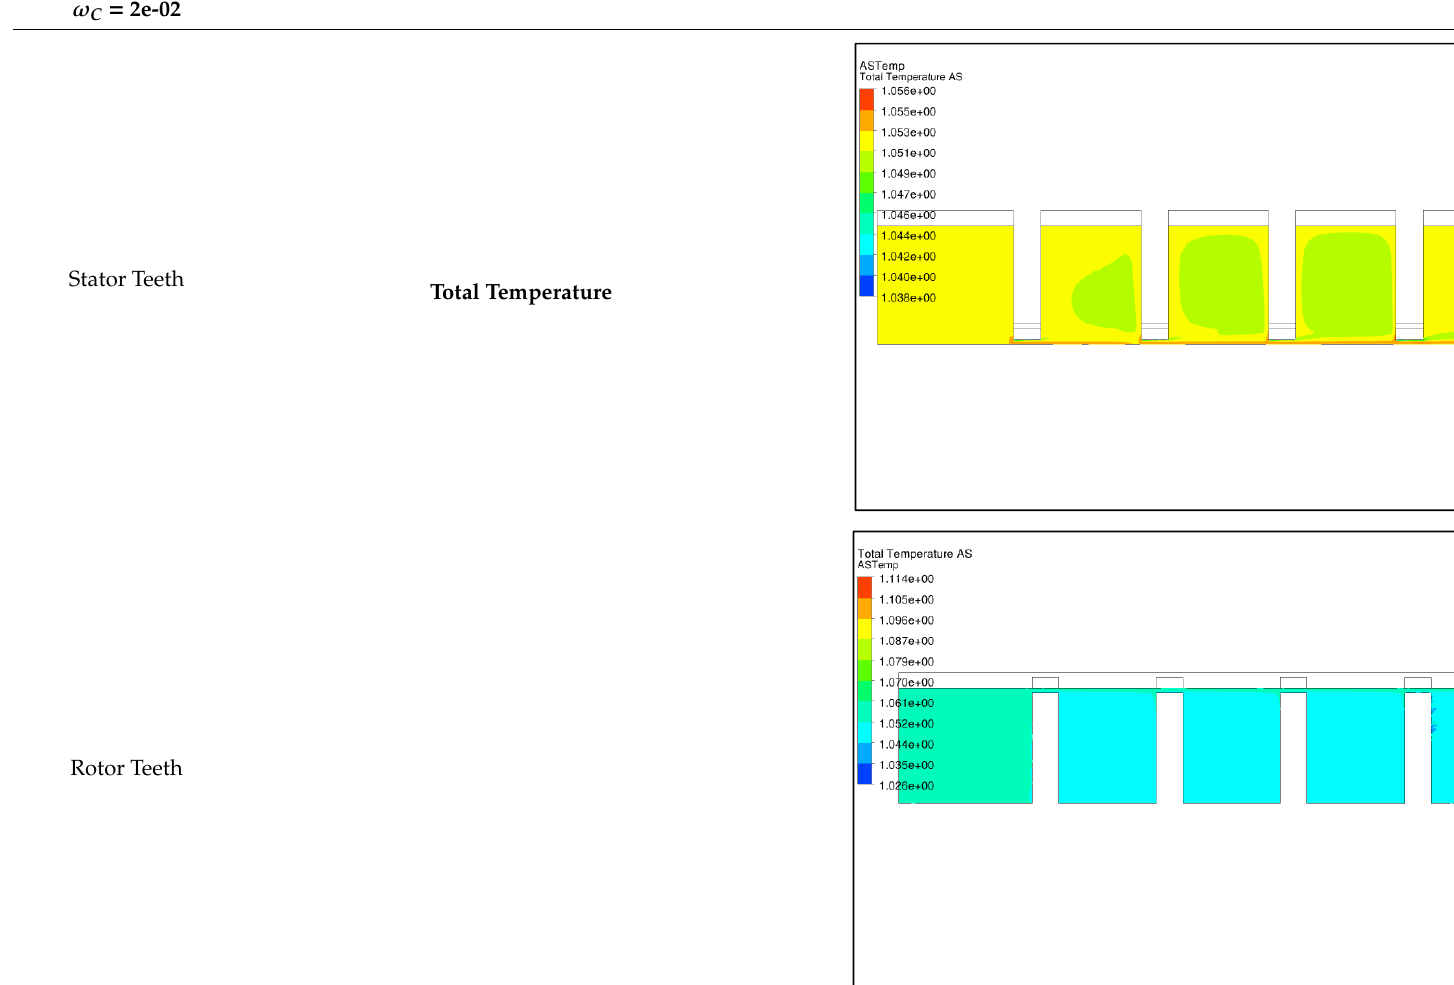
Table A7. Total temperature fields.